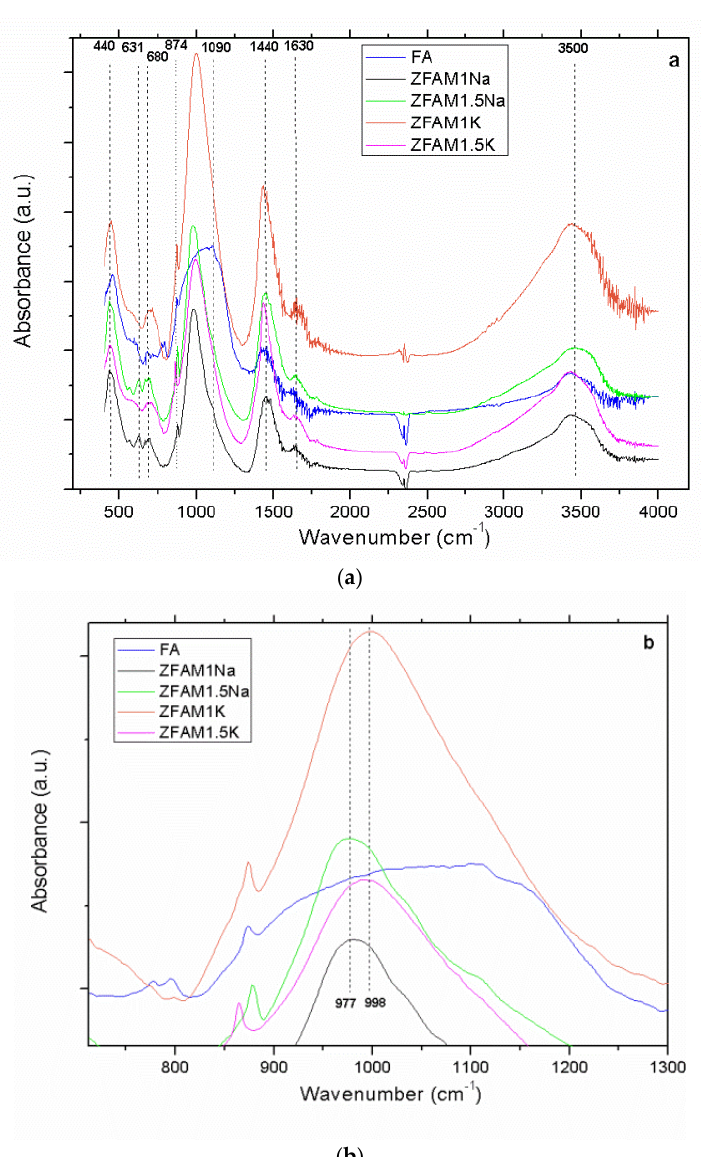
Figure 2. FTIR spectra ( a ) for all synthetic zeolites and raw FA; ( b ) zoomed area of the region between 800 and 1300 cm −1 .